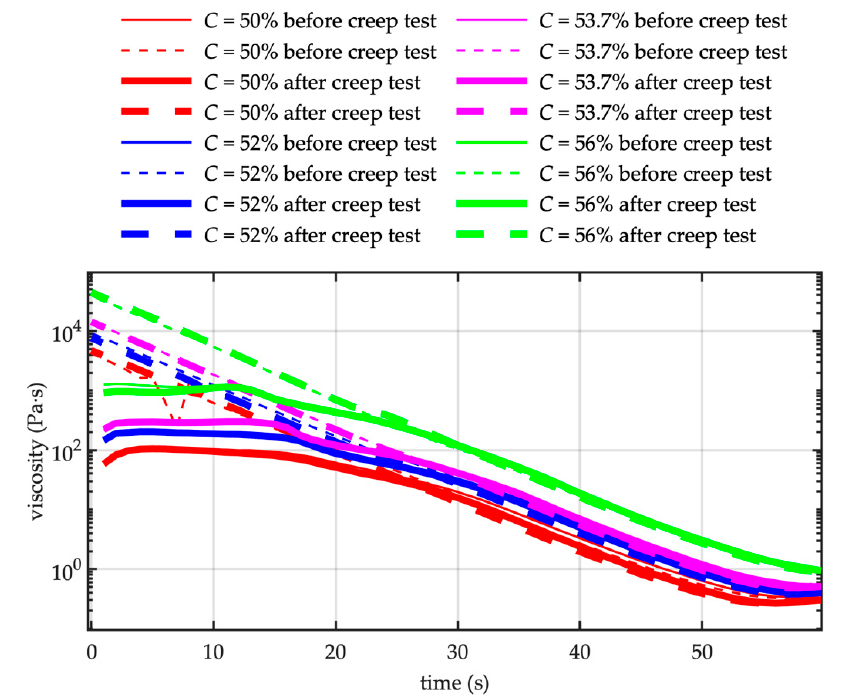
Figure 7. Apparent viscosity derived from the flow curves. Tests carried out before and after creep test, for different value of grain concentration C (runs F21 and F22, F5 and F6, F14 and F15, F18 and F19—see Table 1—in the legend from the top to the bottom). ⎯ increasing shear ramp (time 0–60 s); - - decreasing shear ramp (time 60–0 s).